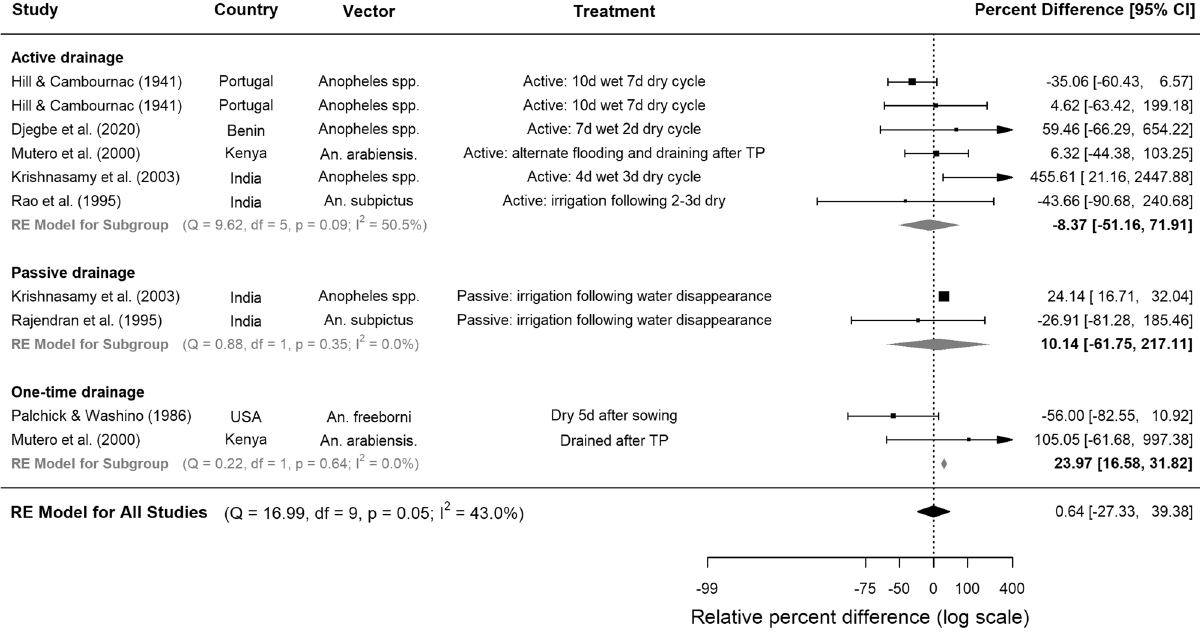
Figure 3. The effect of different intermittent irrigation techniques on larval densities of Anopheles vectors in rice fields. Seven studies were included, conducted between years 1936 and 2016. Squares represent the relative effectiveness of individual studies, where square size represents the weight given to the study in the meta- analysis, with error bars representing 95% CIs; diamonds represent the pooled effects from random effects (RE) sub-group and